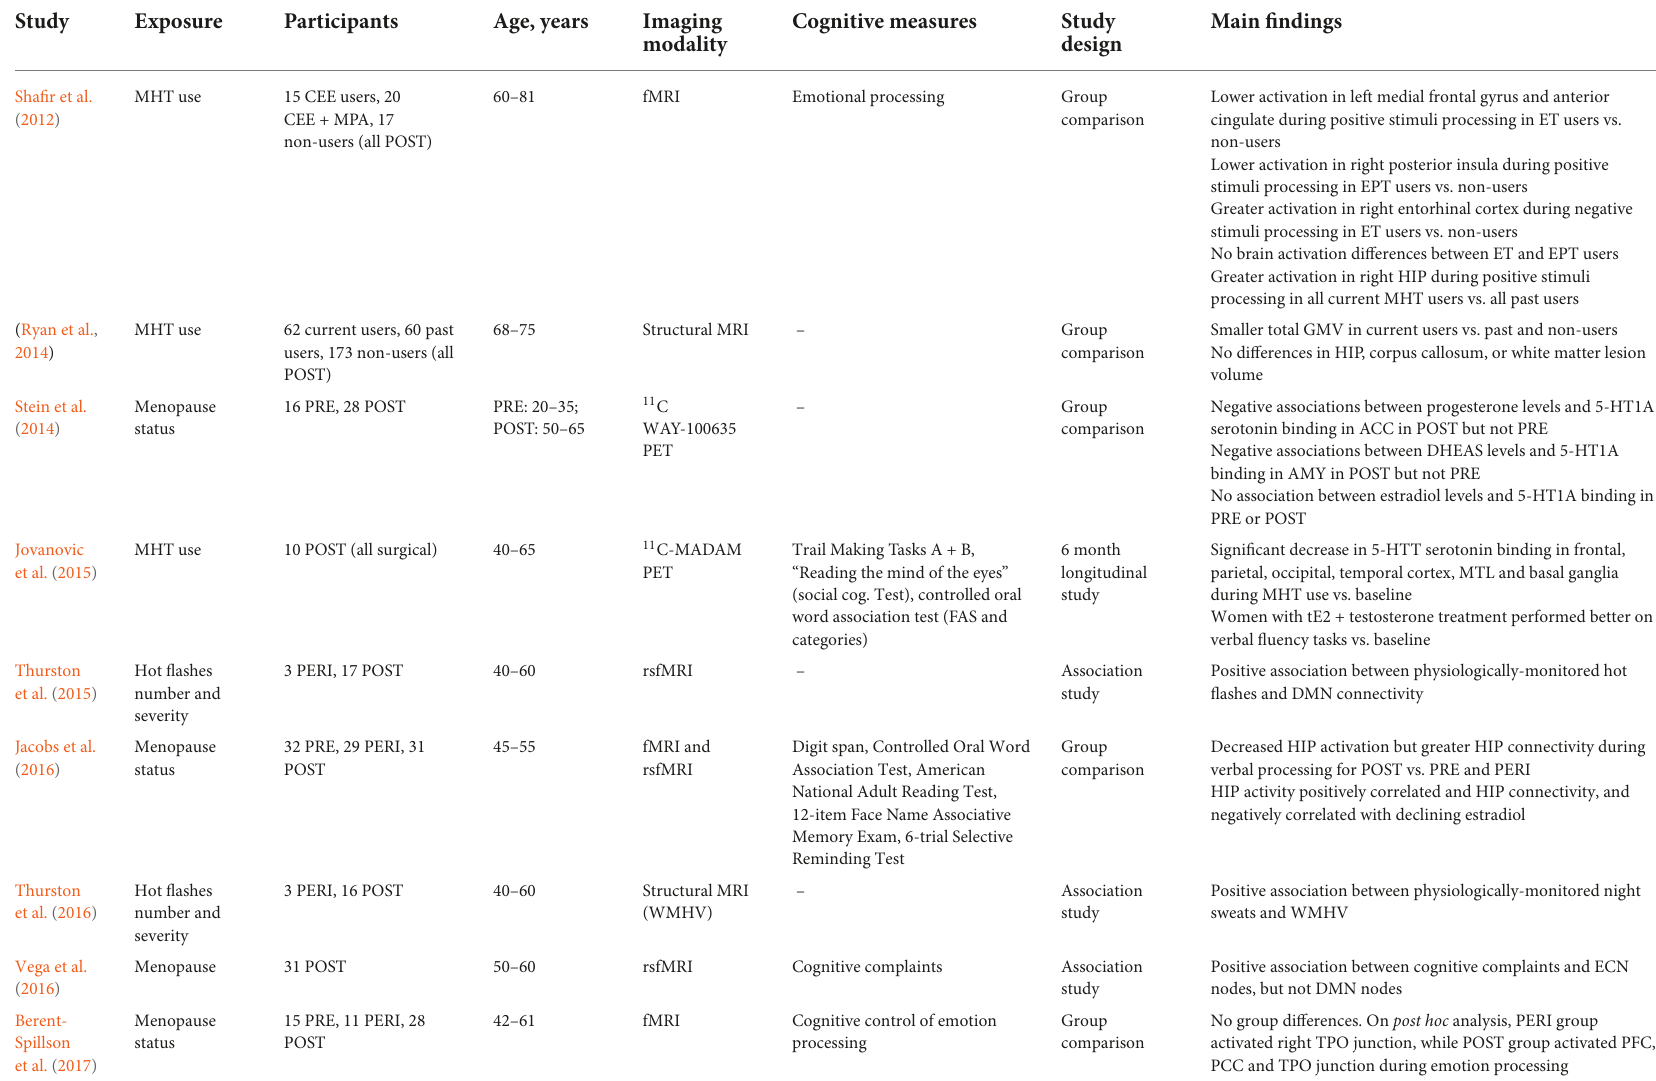
Greater activation in right entorhinal cortex during negative stimuli processing in ET users vs.